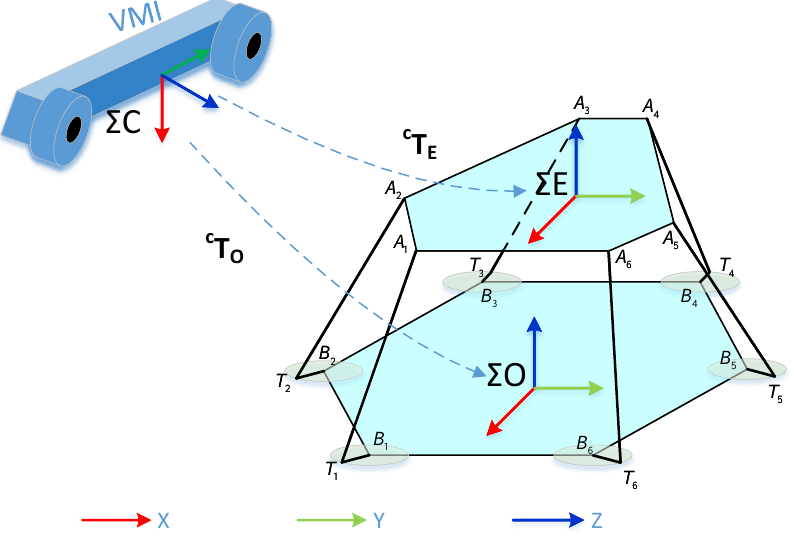
Figure 2. The pose measurement system of a 6-RSS parallel